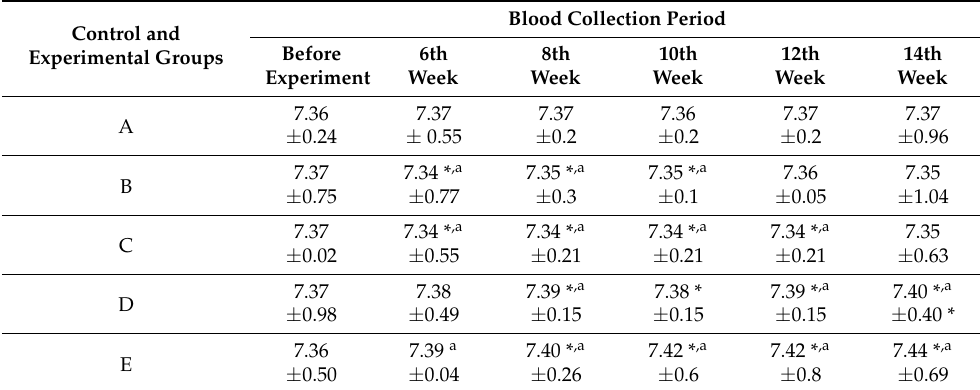
Table 5. Influence of different DCAD diets on blood pH values in turkeys (n = 18; x ± SD). * Significantly differences at p ≤ 0.05 (Student’s t -test) vs. pH values obtained before experiment. Control and Experimental